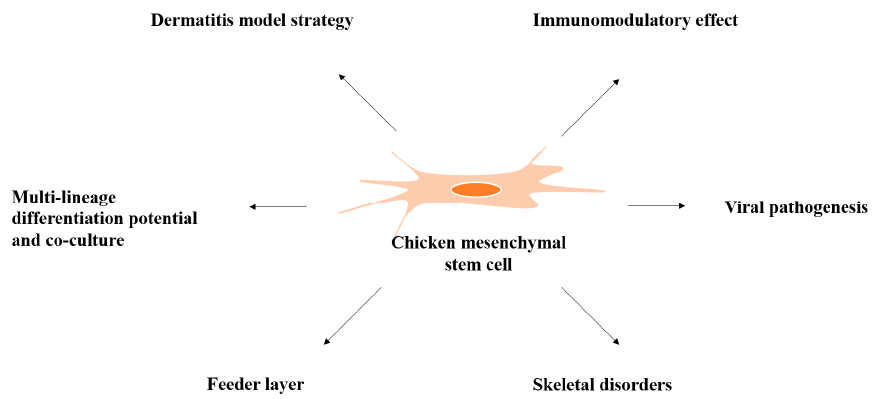
Figure 1. Multifunctional properties of chicken mesenchymal stem cells.